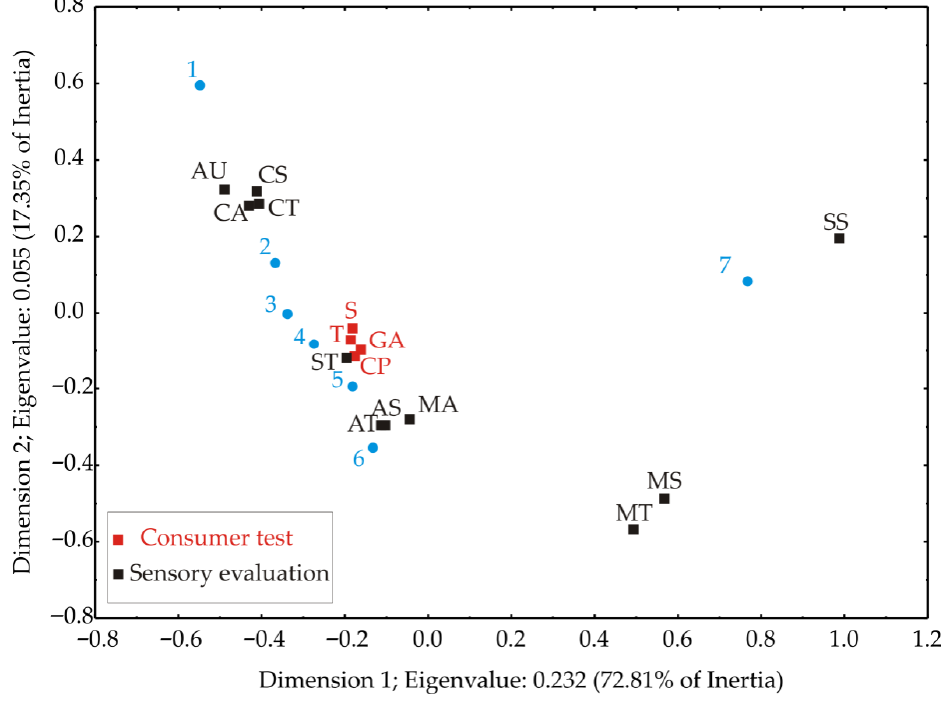
Figure 7. Sensory evaluation and consumer acceptance test of the muffins. ST—sweet taste,